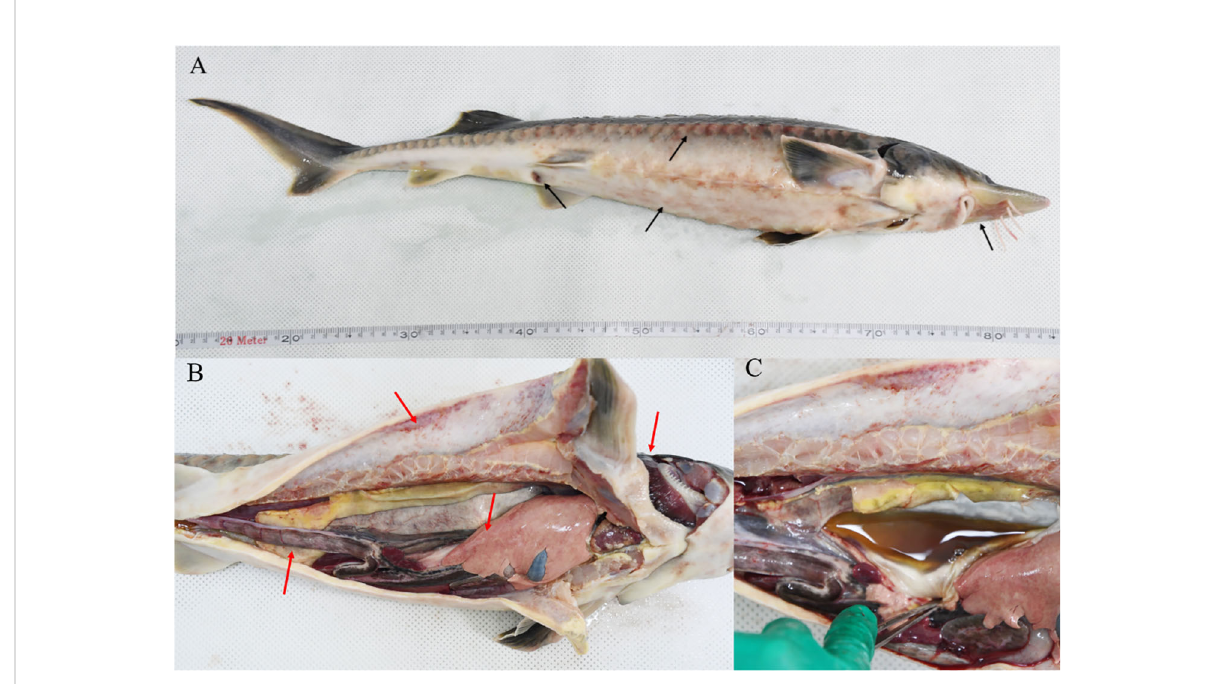
FIGURE 1 Clinical symptoms of hybrid sturgeon: (A) Bleeding around the mouth, abdomen, and both sides of the bony plate; redness and swelling of the anus; whitening of the ventral fi n with slight ulceration (black arrows). (B) Bleeding gill fi laments, bleeding muscles, swollen liver with bleeding spots, red-black intestinal congestion (red arrows). (C) Ascites.